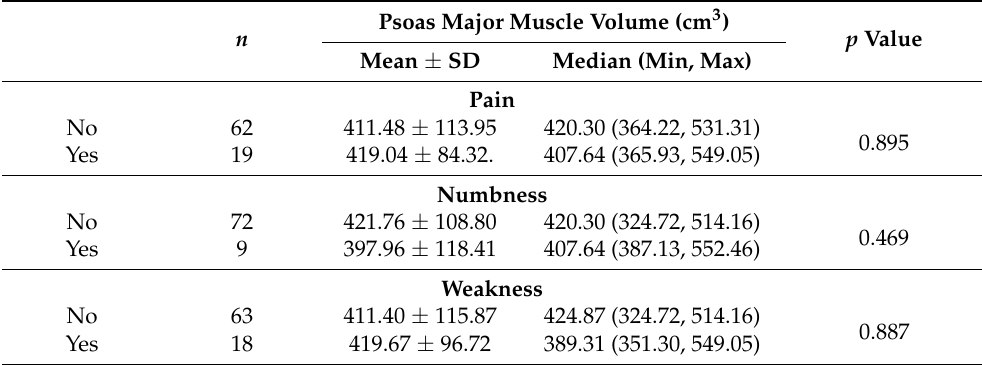
Table 5. Comparison of psoas major muscle volume between two patient